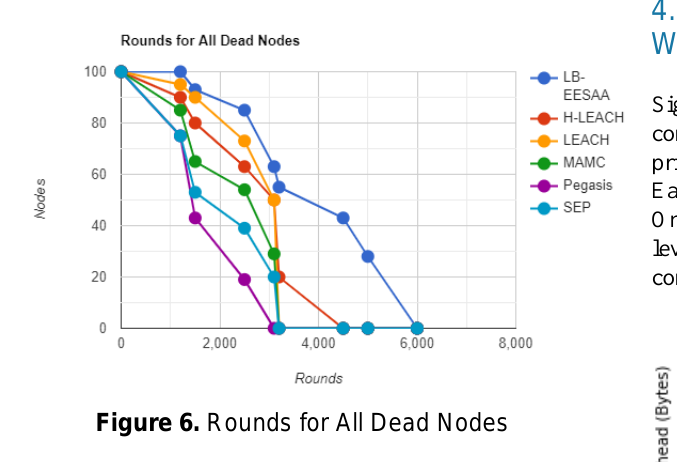
Figure 6. Rounds for All Dead Nodes